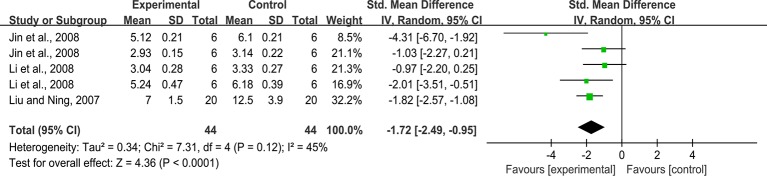
Pooled estimate of relative area of kidney collagen fiber with rhein.